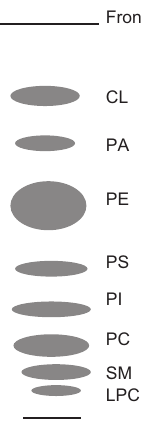
Figure 3 TLC separation of PL classes according to Leray et